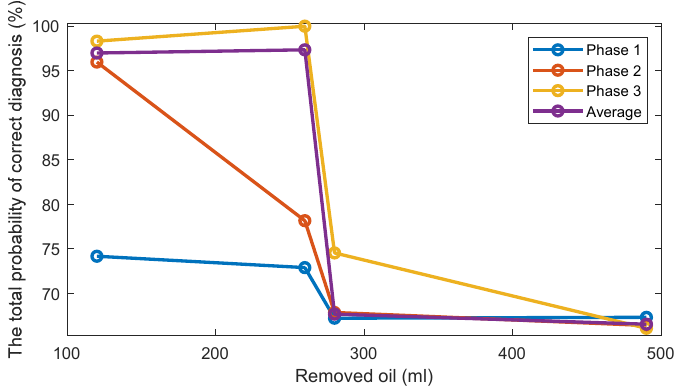
Figure A4. Histograms of Feature 1 (the first harmonic of the supply frequency) for phase 1 of the current signals, comparing the standard oil level (Day1 + Day 2) to 120 mL, 260 mL, 280 mL and 490 mL of removed oil cases.